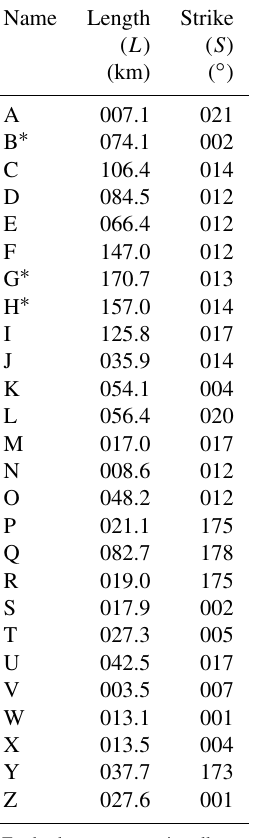
Table 1. VZD length and strike data.